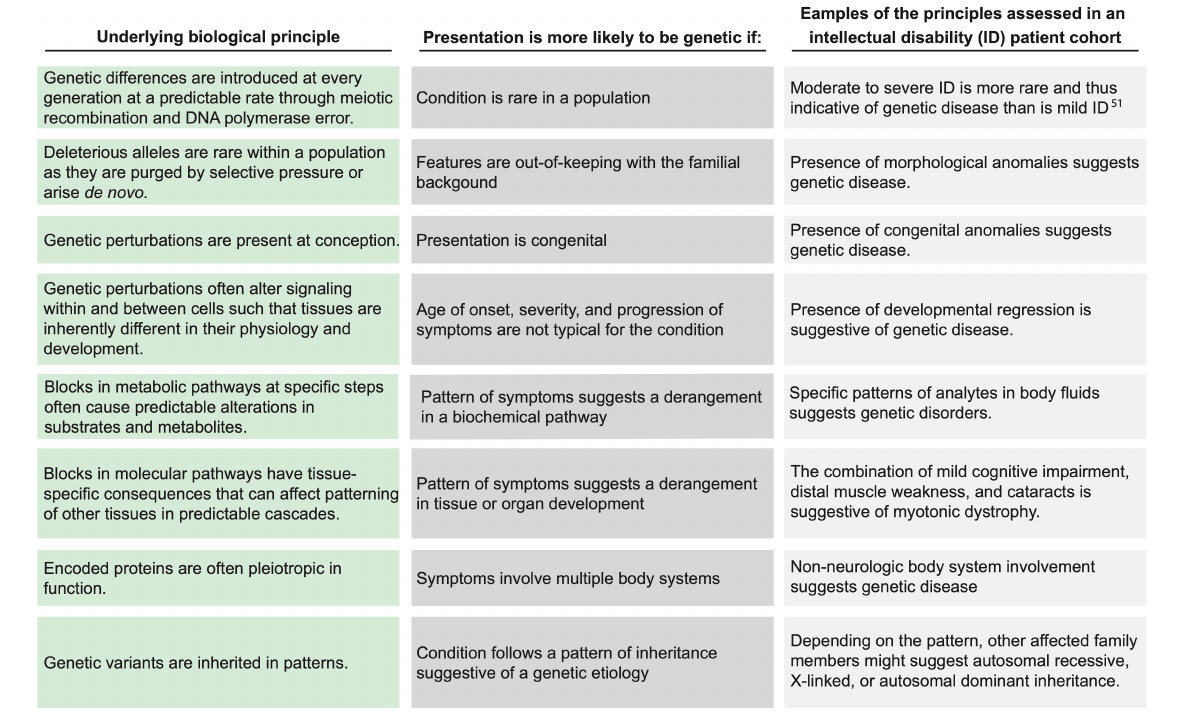
( Figure 2 ). Process mapping of genomic medicine